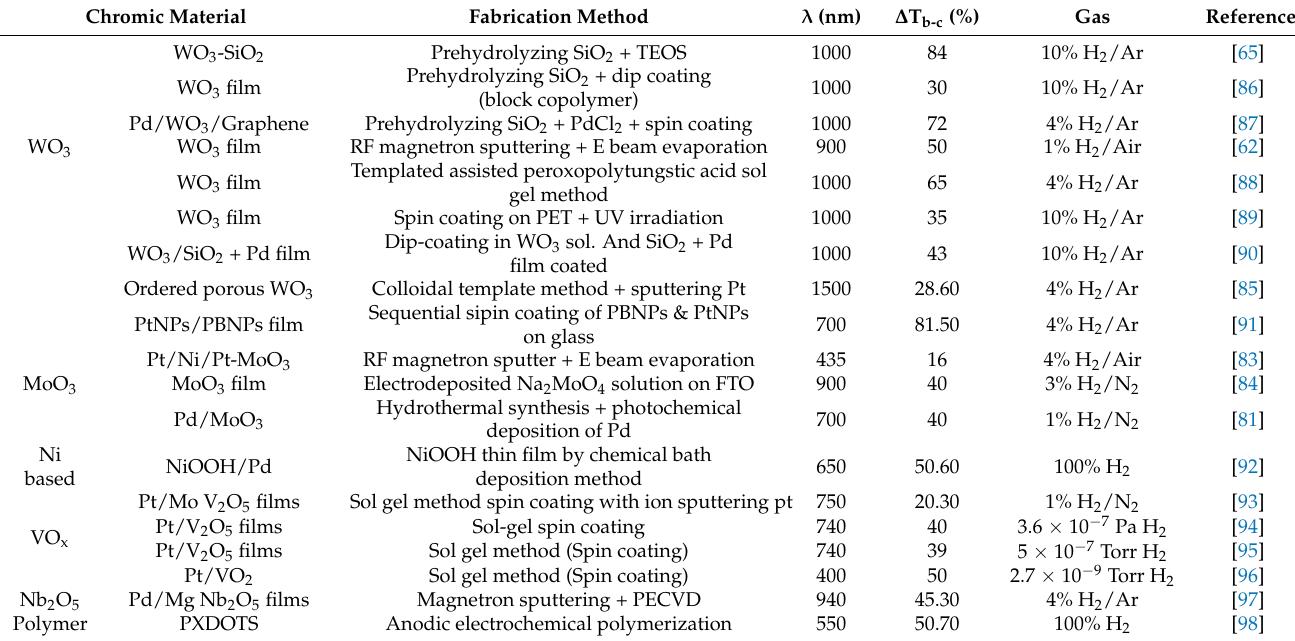
Table 2. Various gasochromic system for hydrogen gas